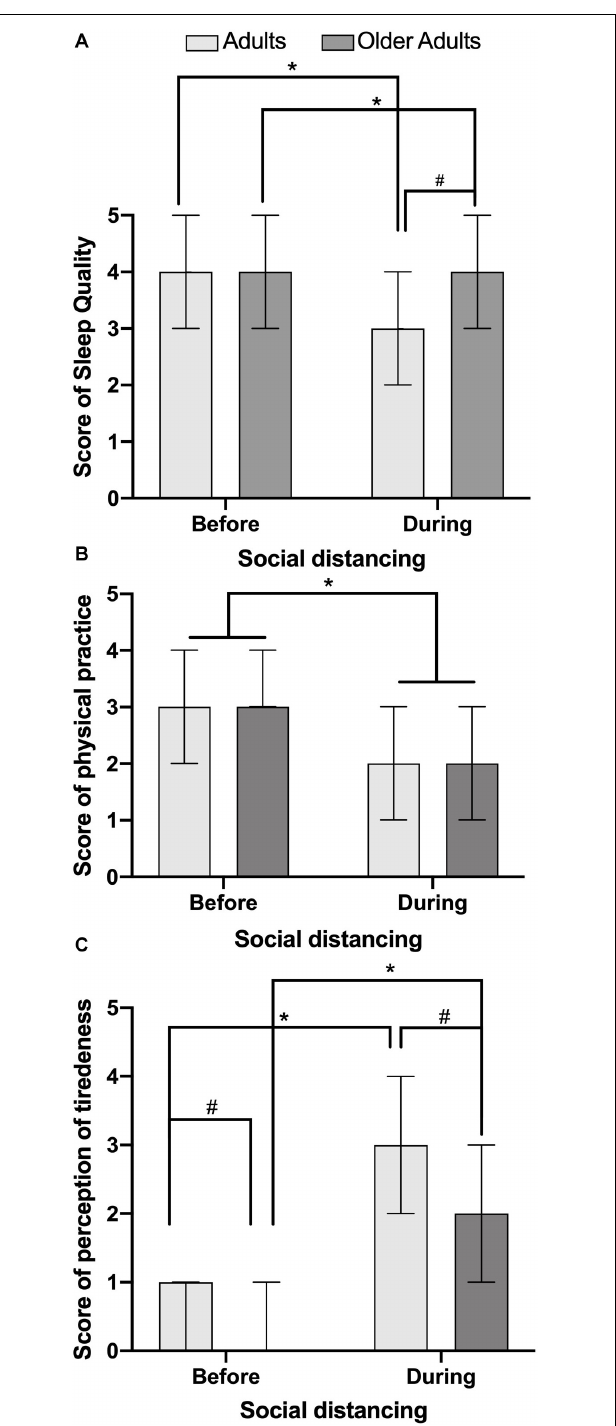
FIGURE 1 | Recall and perception of sleep quality (A) , physical practice (B) and tiredness level (C) for adults and older adults residents in São Paulo, respectively of periods before and during the social distancing due to COVID-19. ∗ Represents statistical differences intragroup before and during the social distancing by Wilcoxon test ( p < 0 . 05). # Represents statistical difference intergroups, before and during the social distancing due COVID 19 pandemic by U Mann-Whitney test ( p < 0 .